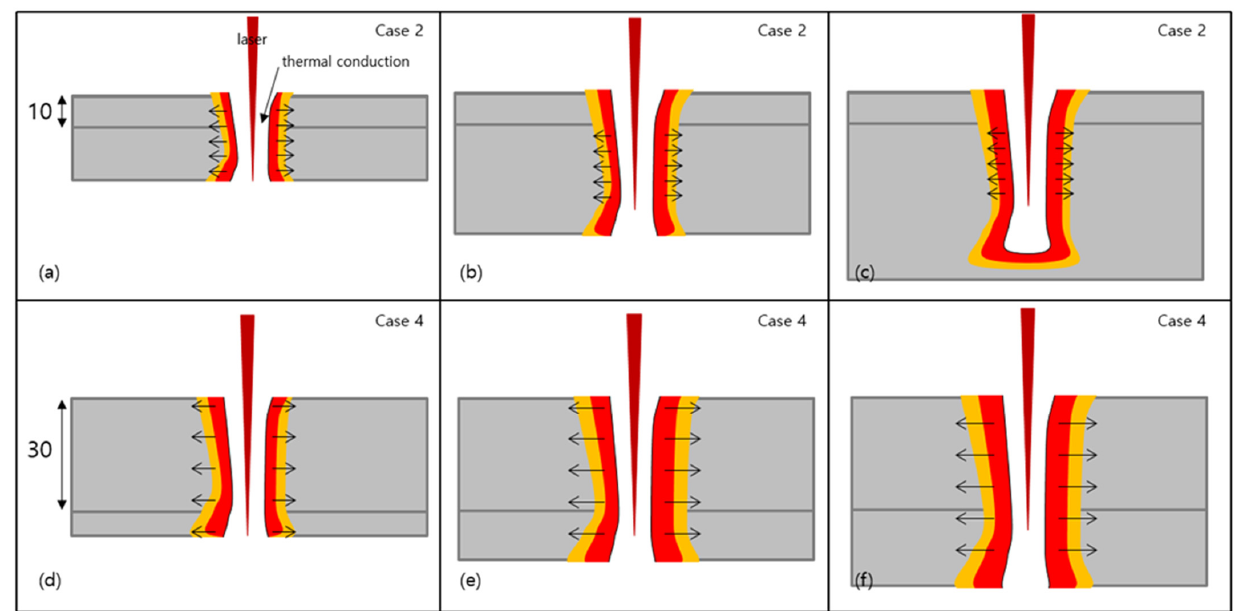
Figure 16. Visualization of thermal conduction according to the cut position of the specimen. (front side view). ( a ) case 2: 15 mm cut point, ( b ) case 2: 30 mm cut point, ( c ) case 2: 40 mm cut point, ( d ) case 4: 15 mm cut point, ( e ) case 4: 30 mm cut point, and ( f ) case 4: 40 mm cut point.